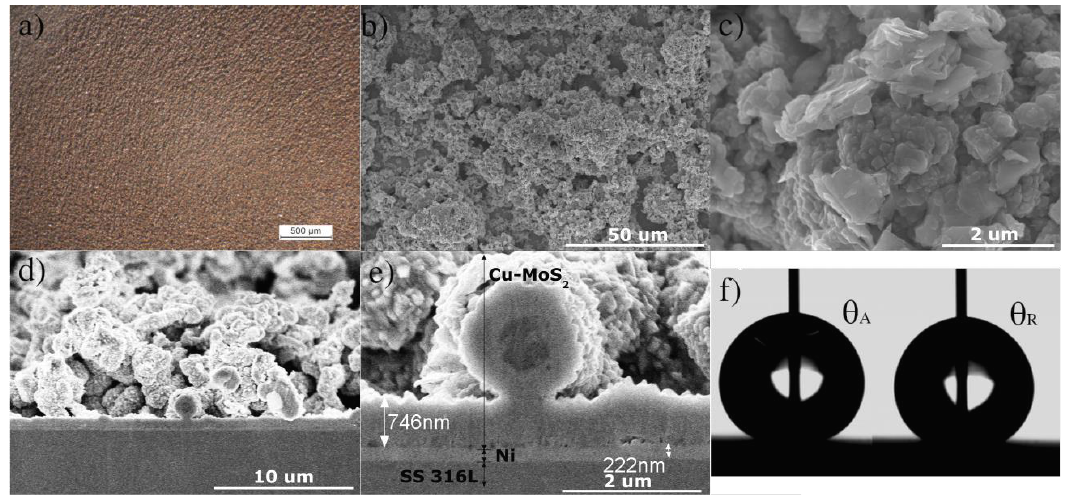
Figure 2. ( a ) Optical macrograph of a Cu–MoS2 composite coating; ( b ) and ( c ) SEM micrograph of the coating in a) showing a hierarchical structure; ( d ) and ( e ) SEM micrograph of a transversal cut done with ion milling of the Cu–MoS2 composite coating; ( f ) images taken during advancing and receding contact angle measurements of the sample shown in ( a ) with ϴ A equal to 158.2° and contact angle hysteresis 1.8°.